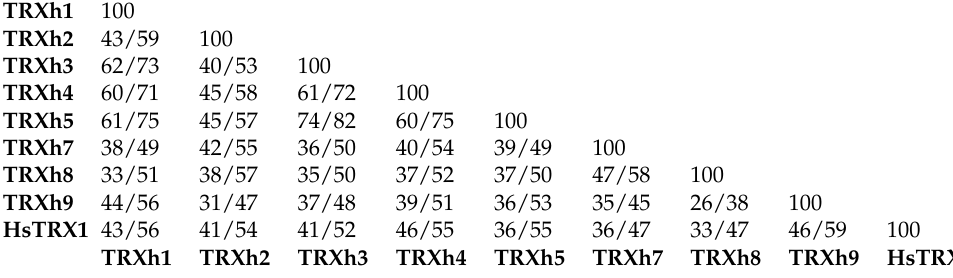
Table 3. Percent amino acid identity/similarity of Arabidopsis h-type TRXs and human TRX1. High- lighted in red are the percent identity/similarity of h-type TRX in comparison to TRXh5. Data were assessed using SIAS (http://imed.med.ucm.es/Tools/sias.html, accessed on 26 April 2022) and the EBLOSUM62 matrix with default parameters. Values were rounded to the nearest integer.